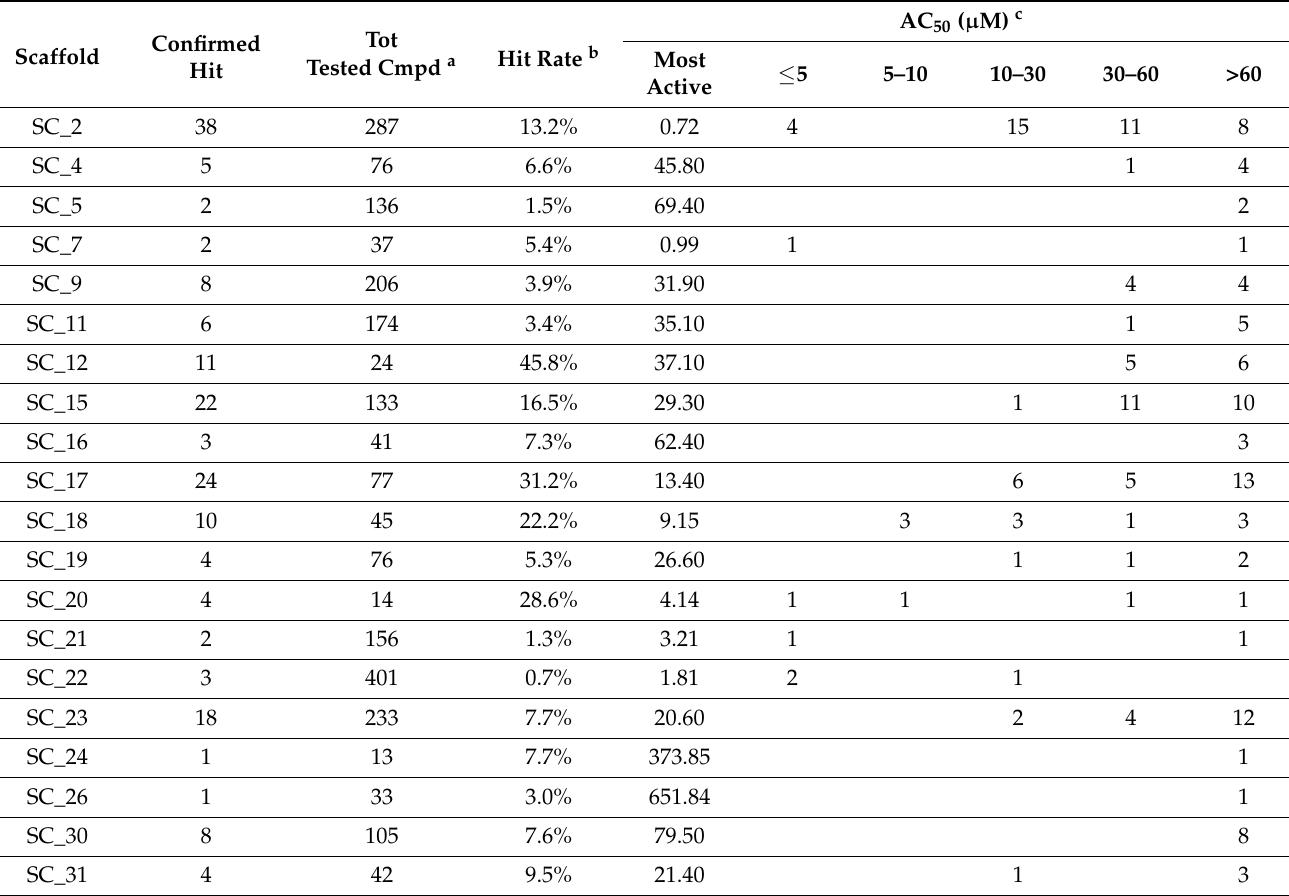
Table 1. Analysis of the hit rate and AC 50 distribution across